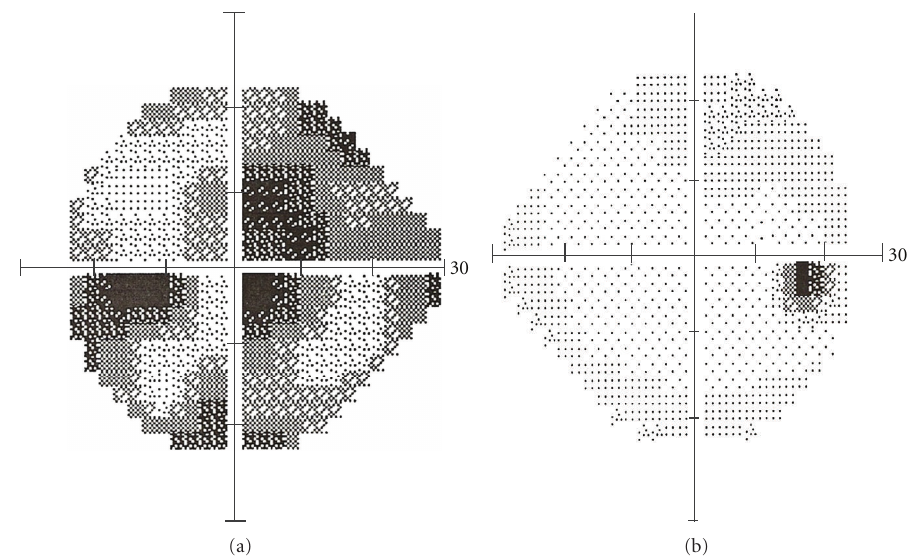
Figure 1: Visual fields of the patient at presentation. The RE is normal, and the LE shows a deep central scotoma (V/A 20/40).